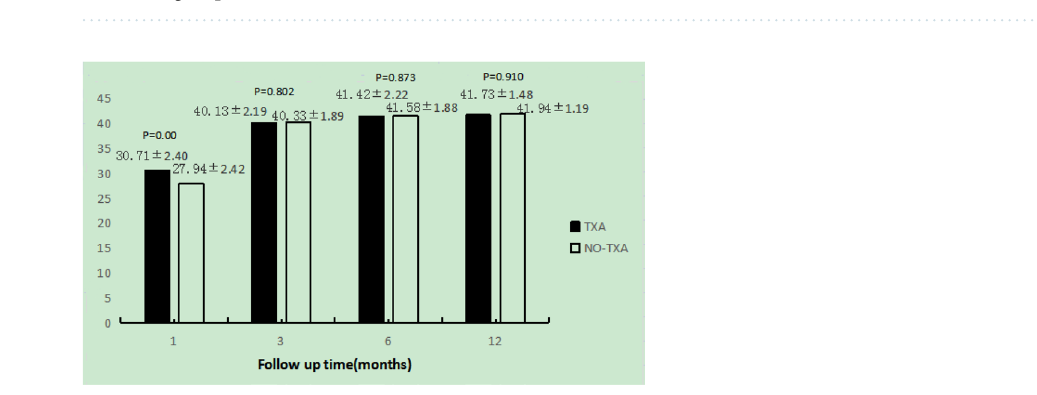
Figure 2. The AOFAS score of both groups at each follow up. The TXA group is shown as black bars and the NO-TXA group is shown as white bars.